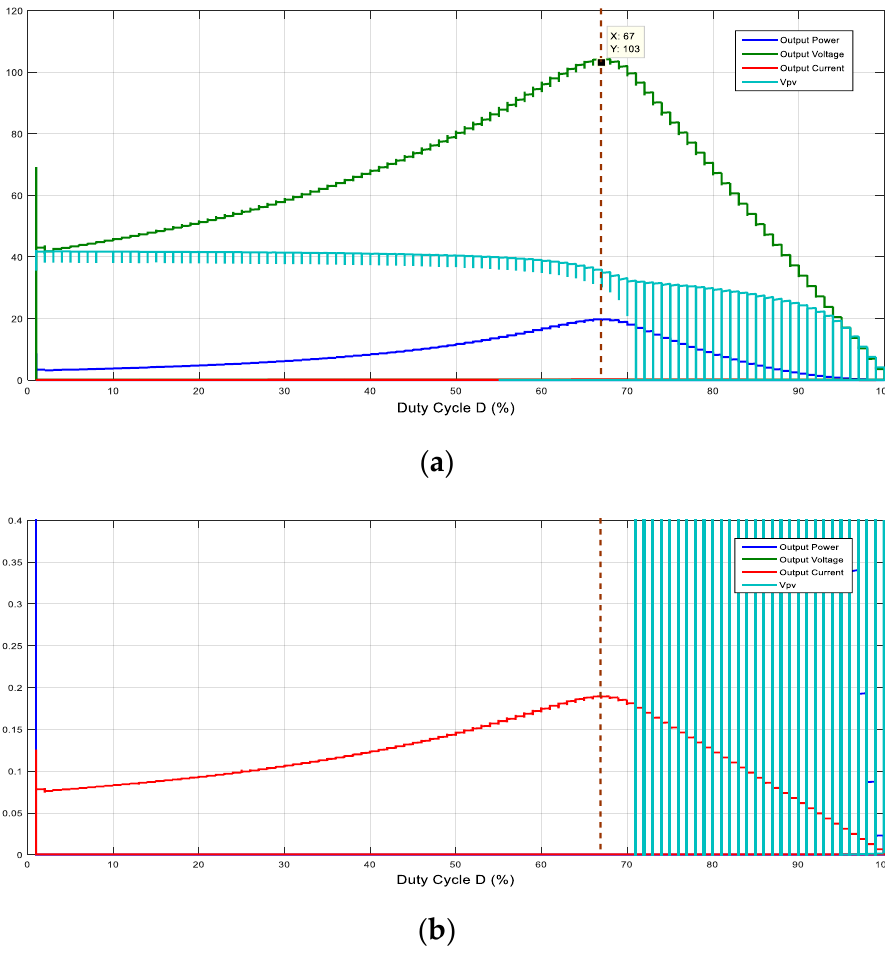
Figure 4. Boost converter: graph of output current, output power, and V PV with duty cycle.